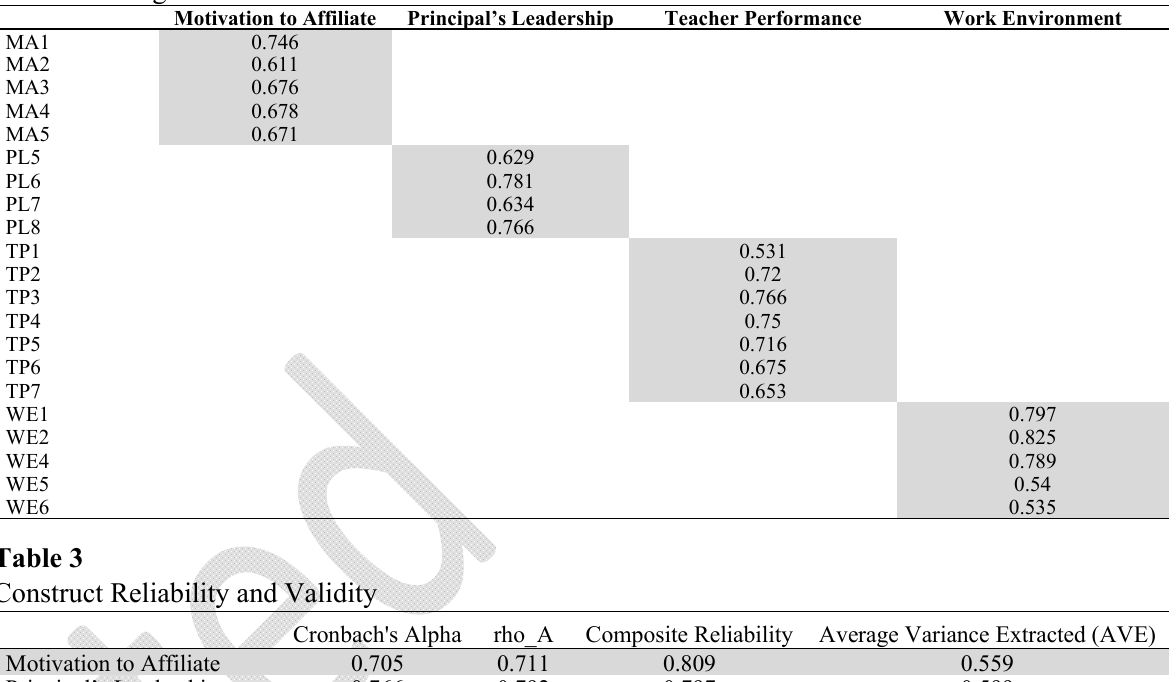
Factor Loadings